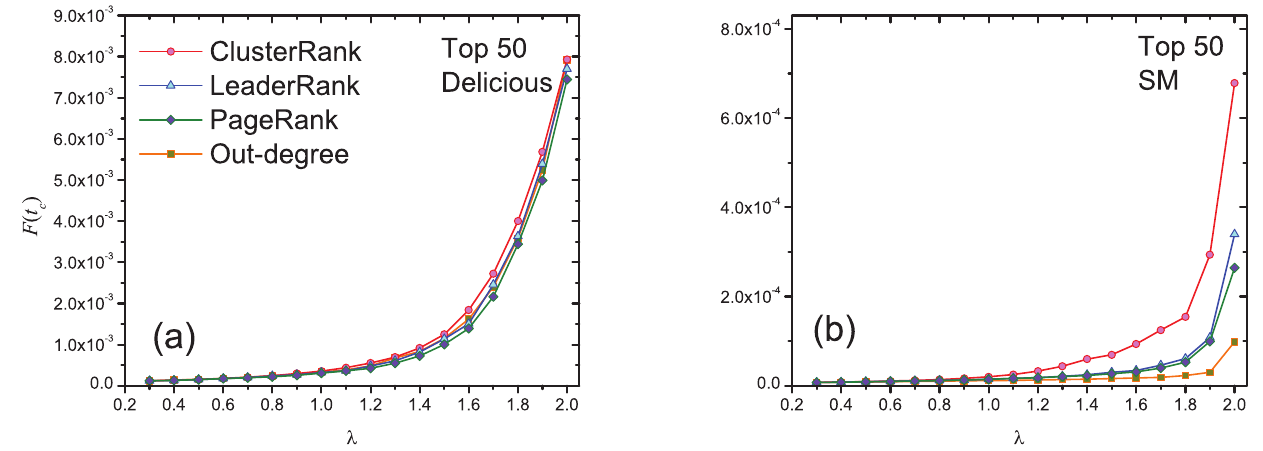
Figure 6. The dependence of F ( t c ) on parameter l . The initially infected nodes are the top-50 nodes obtained by out-degree centrality (squares), PageRank (diamonds), LeaderRank (triangles) and ClusterRank (circles). We set b ~ 1 = S k out T . Each data point is obtained by averaging over